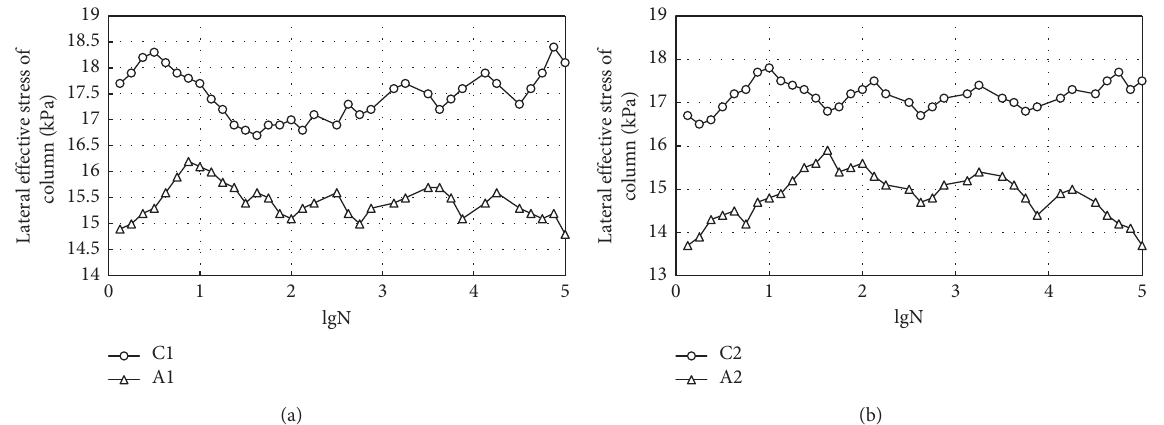
Figure 11: Lateral effective stress of the column: (a) single column; (b) single column composite foundation.